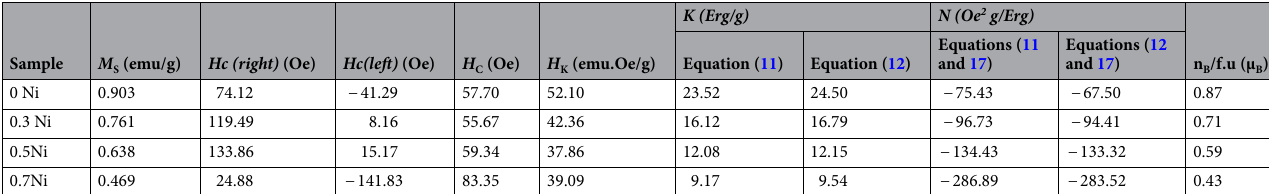
Table 2. The estimated parameters for the prepared